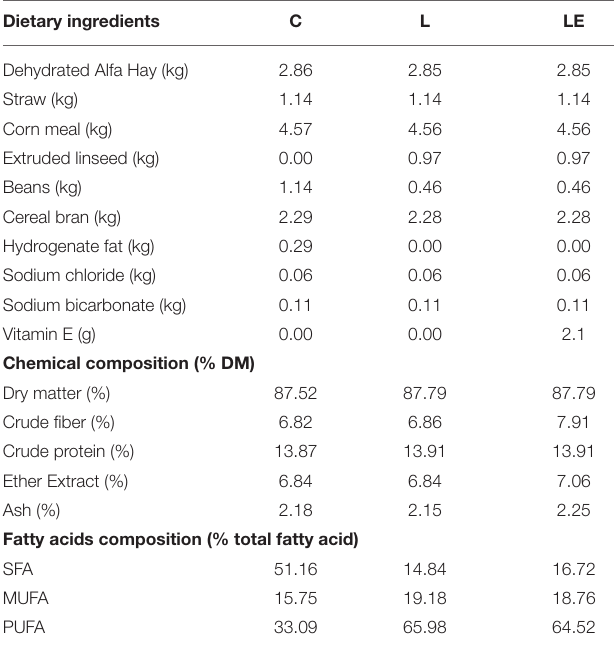
TABLE 1 | Ingredients of the three experimental diets: C (control), L (linseed), and LE (linseed + vitamin E). Dietary